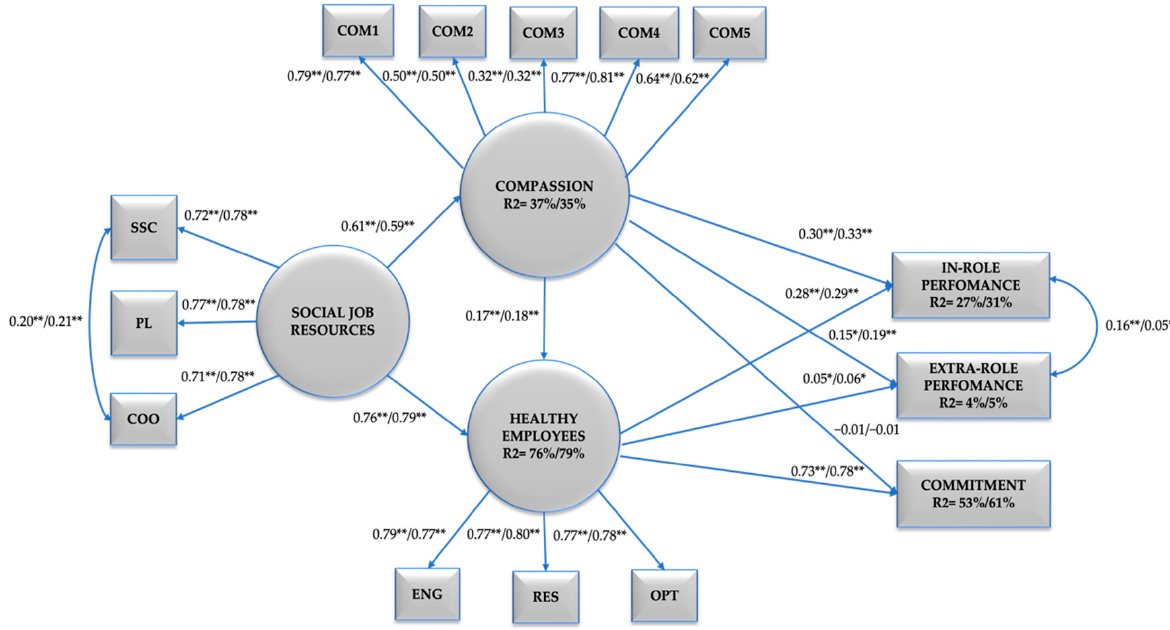
Figure 3. Final Model: Structural Model of Compassion, Social Job Resources, Healthy Employees and Healthy Organisational Outcomes in two samples, Women (N = 303) and Men (N = 303). Note. SSC = Social Support Climate, PL = Positive Leadership, COO = Coordination, COM1 = Compassion Item 1, COM2 = Compassion Item 2, COM3 = Compassion Item 3, COM4 = Compassion Item 4, COM5 = Compassion Item 5, ENG = Engagement, RES = Resilience, OPT = Optimism, IP = Intra-Role Performance, EP = Extra-Role Performance, COMM = Commitment. ** p < 0.01, * p < 0.05. The data on the left of the bar correspond to women and those on the right to